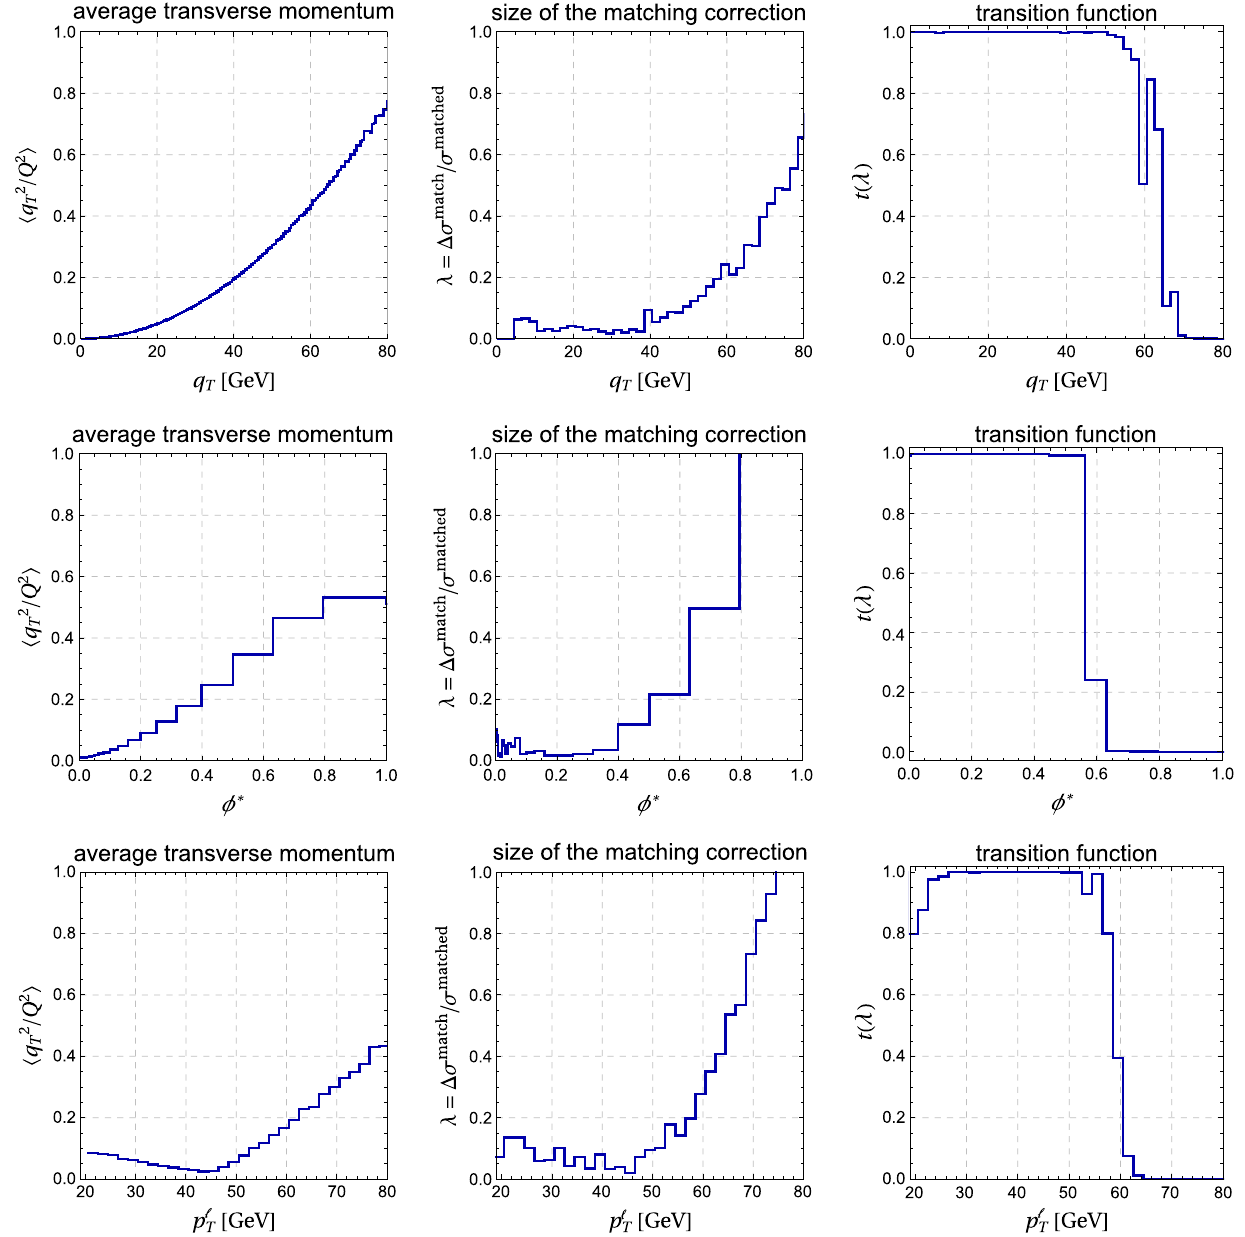
Fig. 6 Average transverse momentum, size of the matching correction and transition function for the observables q T , φ ∗ and p (cid:4) values were computed using resummed events with q T < Q